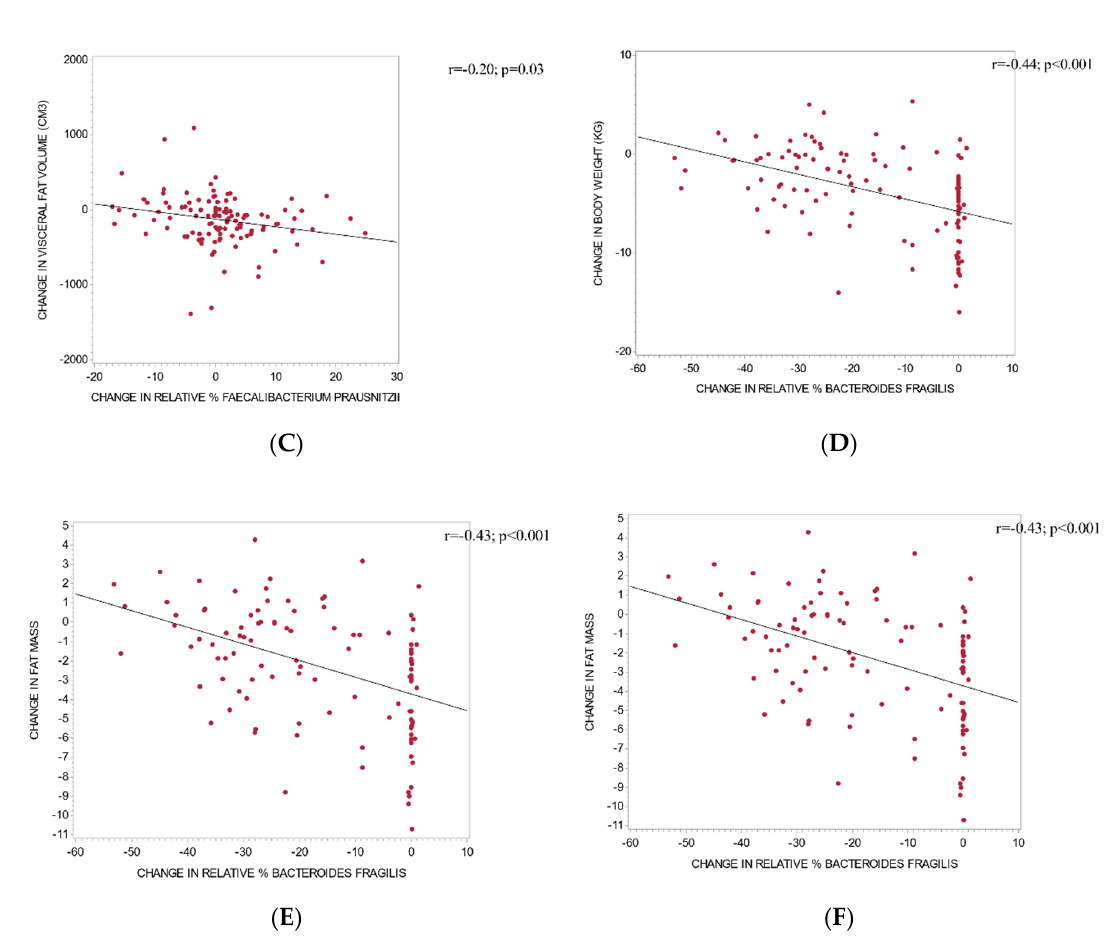
Figure 2. Correlations between changes in relative abundance of gut bacteria and changes in metabolic outcomes: Correlations between changes in relative abundance of Faecalibacterium prausnitzii and changes in body weight ( A ), fat mass ( B ), and visceral fat ( C ); and correlations between changes in the relative abundance of Bacteroides fragilis and changes in body weight ( D ), fat mass ( E ), and visceral fat ( F ).